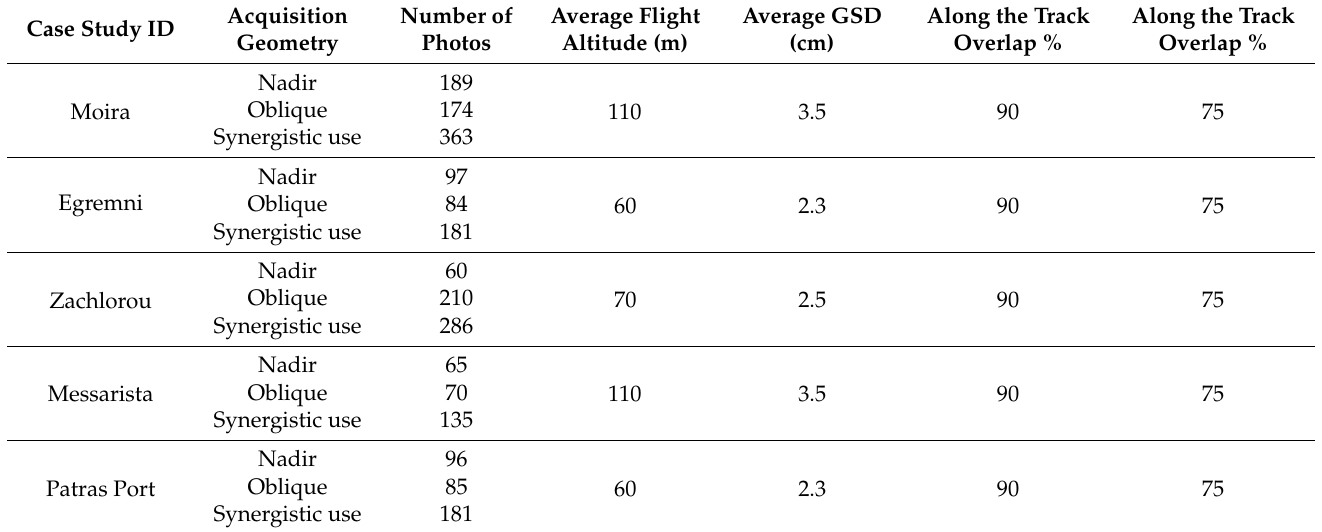
Table 2. Characteristics and parameters of UAV campaigns.